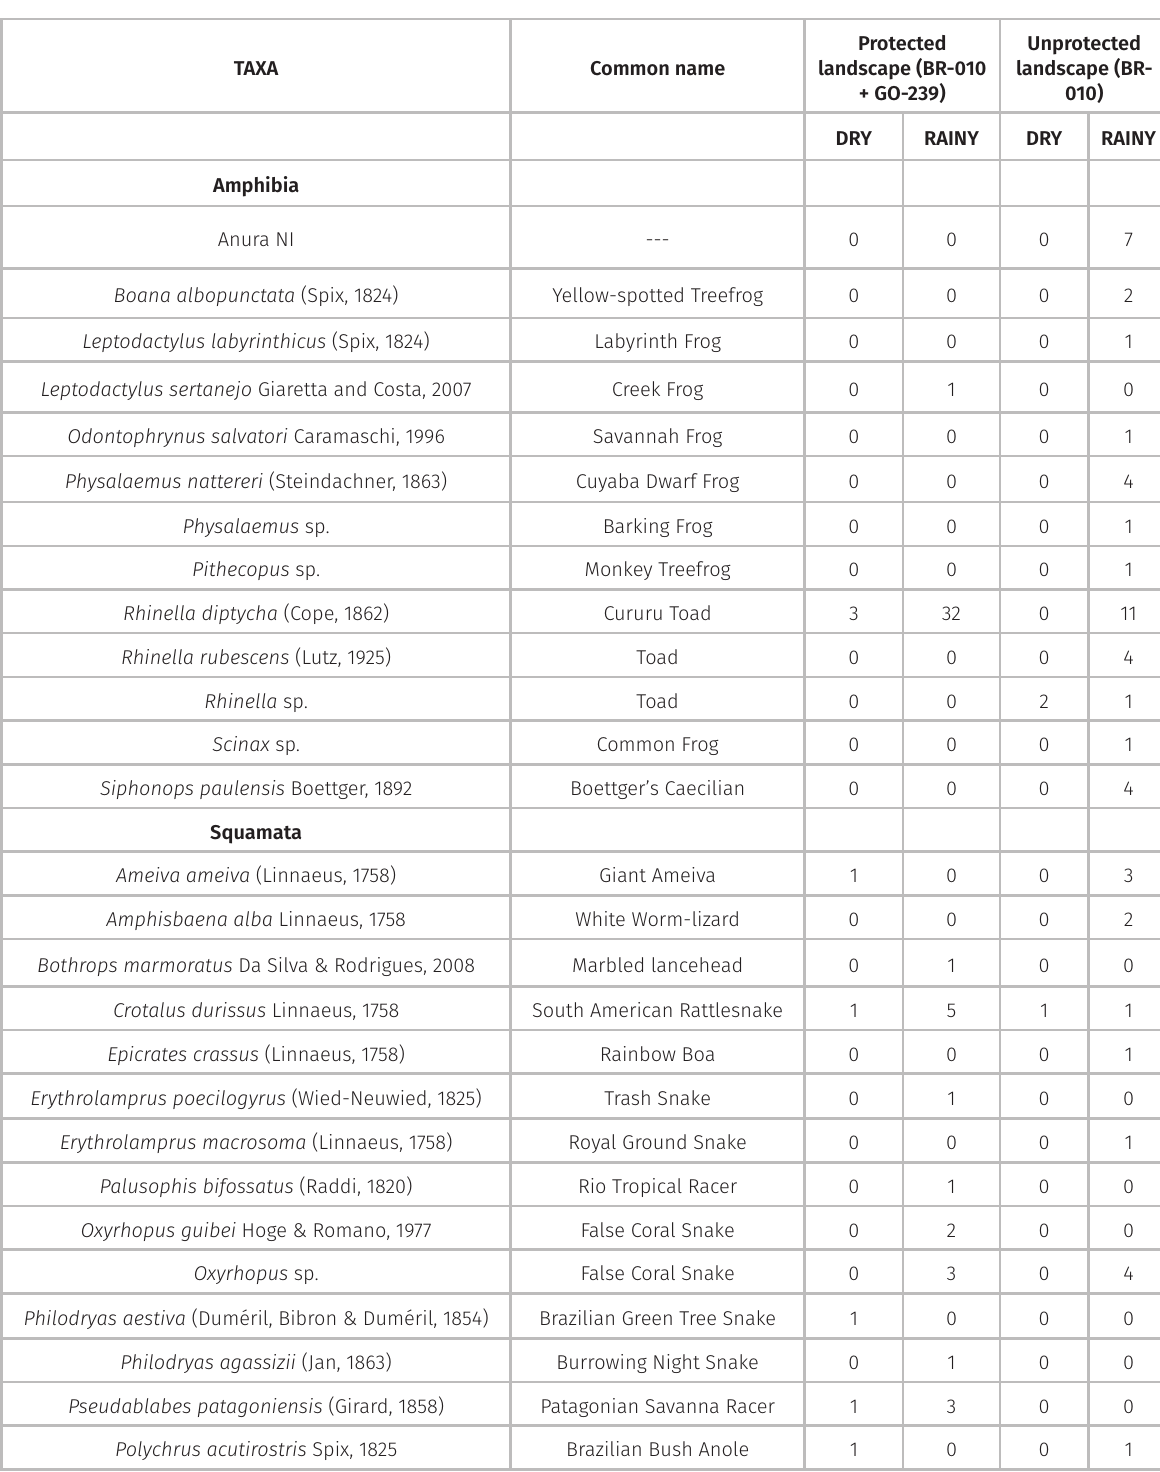
Table I. Number of wildlife roadkill records obtained in the unprotected and protected landscapes. Taxonomic group/species = lowest taxonomic level associated with roadkill (genera/species); Dry/Rainy = number of records per